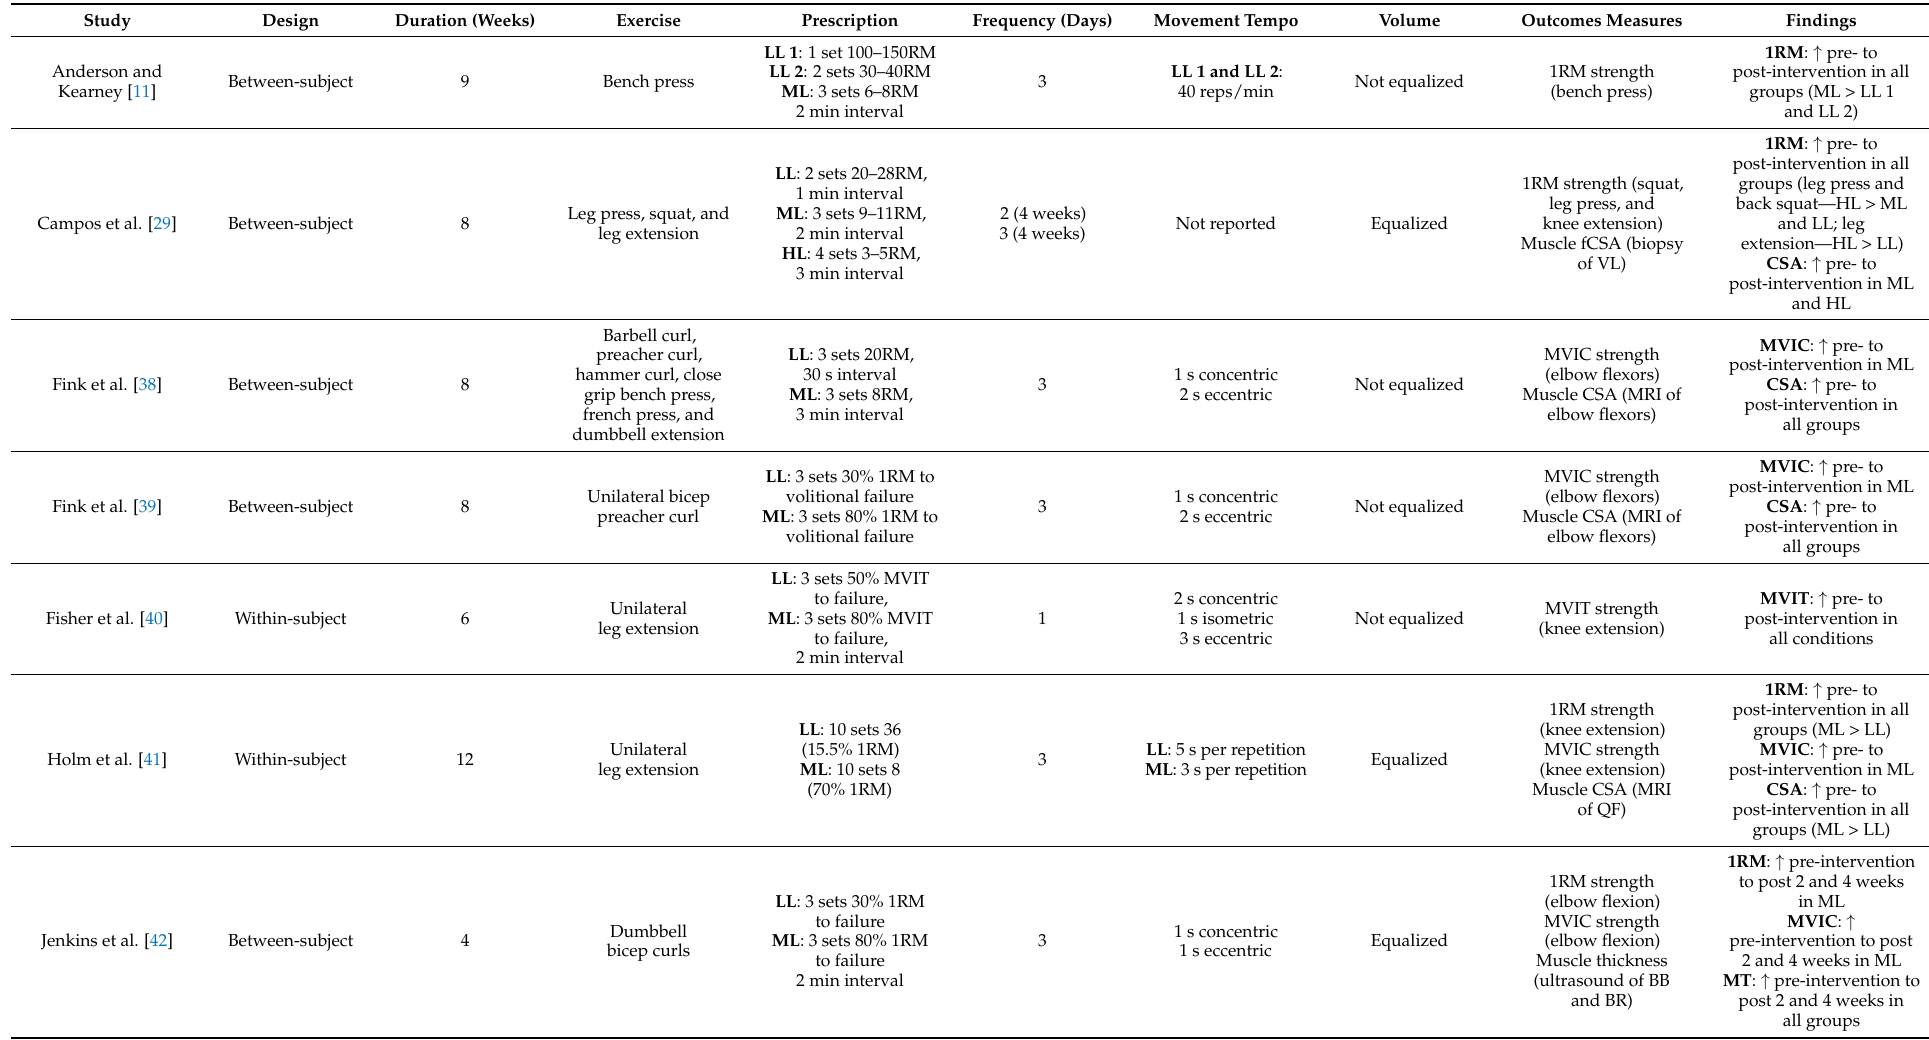
Table 3. Summary and characteristics of the studies included in the